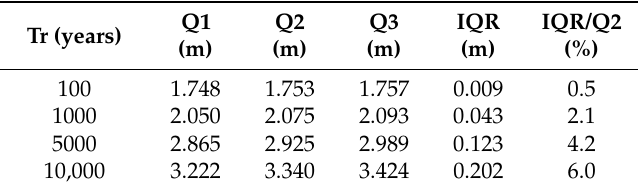
Table 2. Values of the first (Q1), second (Q2), third (Q3) quartiles, the interquartile range (IQR), and the relative value of the IQR, against Q2, for different return periods (Tr) of maximum water reservoir levels. Values are represented as the water height above the Flood Control Level.